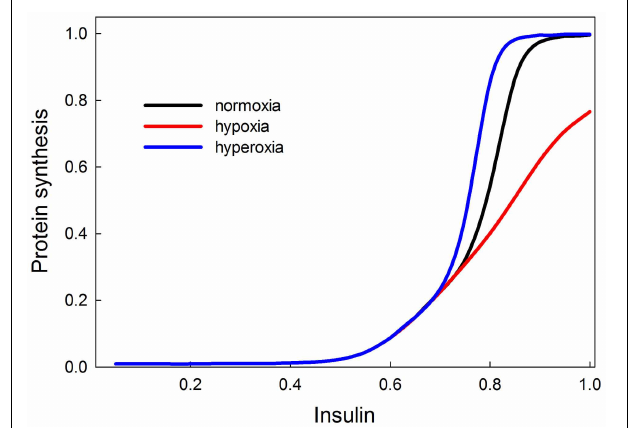
FIGURE 11 | Effects of oxygen on protein synthesis (growth), mediated by the insulin and TOR signaling pathways are most strongly observed at high insulin signaling levels ( > 0.7). This suggests that in poor nutritional conditions, hypoxia or hyperoxia are unlikely to have strong effects on growth and size; only in good nutritional conditions will oxygen show an effect. Hypoxia decreases the rate of insulin-stimulated protein synthesis. Hyperoxia causes protein synthesis to reach its saturating rate at a slightly lower level of insulin signaling, so it has a slight stimulatory effect for insulin between 0.7 and 0.8. At levels of insulin signaling > 0.8, hyperoxia provides no additional stimulation of growth because growth rate has attained its